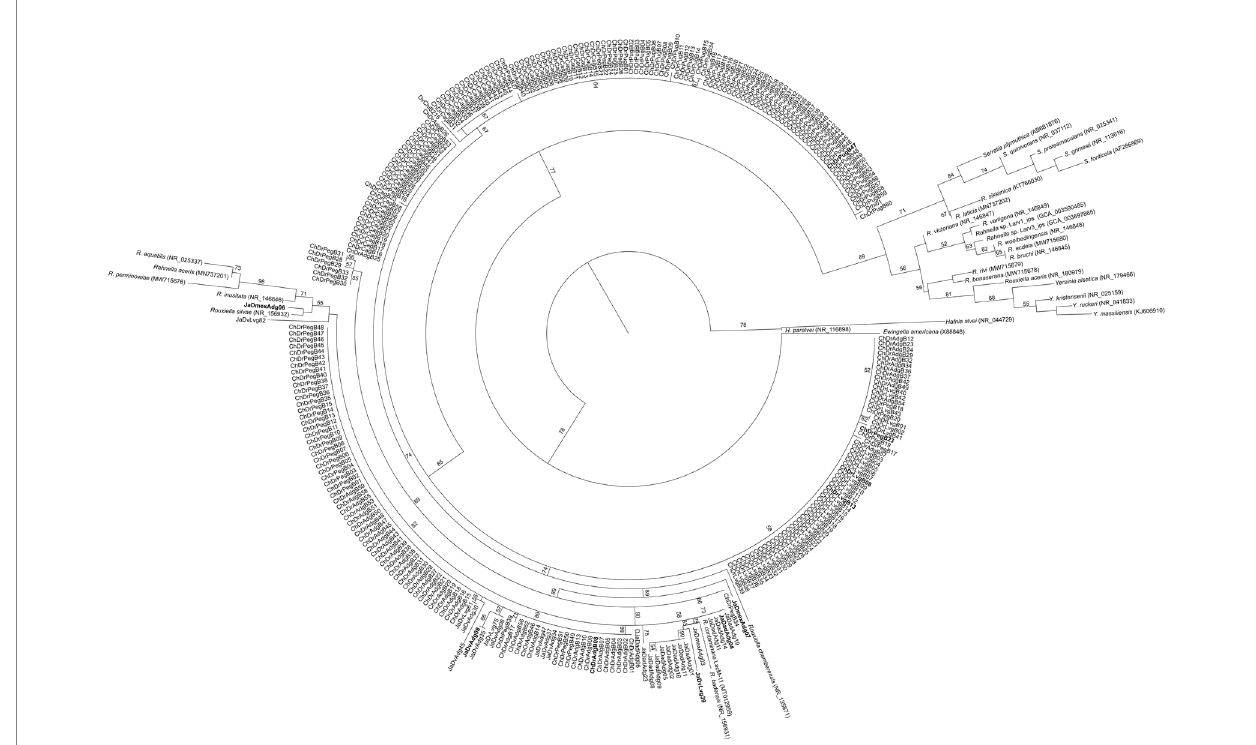
FIGURE 1 Maximum likelihood phylogeny of the 16S rRNA sequences of 300 Rahnella isolates and type strains of the genus Rahnella. The nucleotide substitution model used was GTR with a gamma parameter of 0.693. Bootstrap values >50% are shown at nodes. In bold are the sequences selected for other analyses in this study.